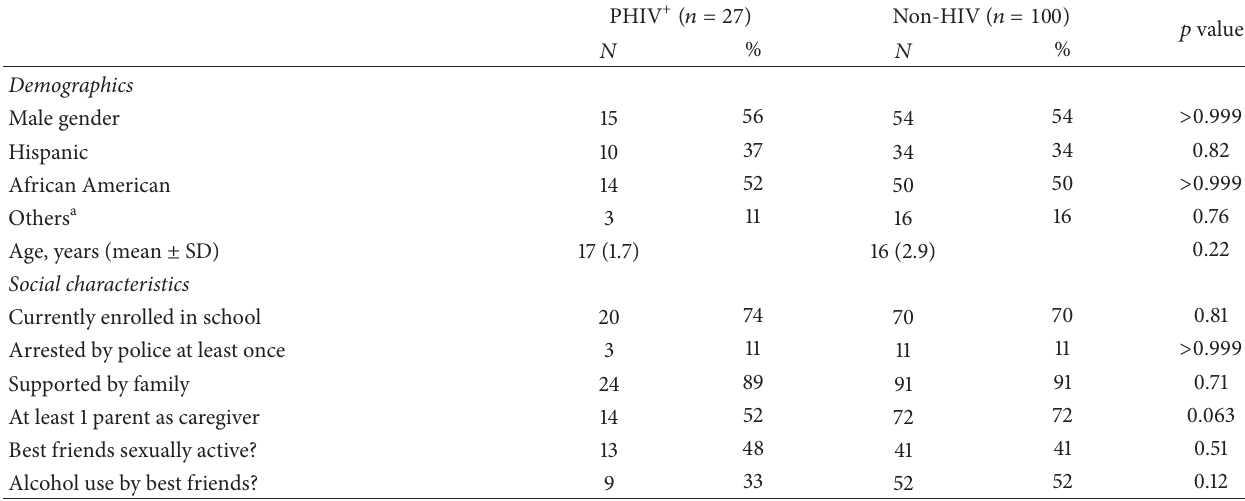
Table 1: Demographics and social characteristics of 127 perinatally HIV-infected (PHIV + ) and HIV-uninfected adolescents (non-HIV).